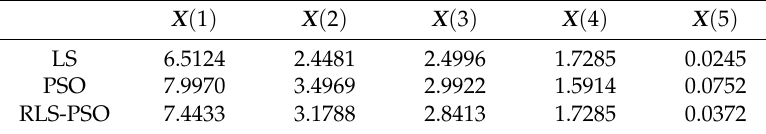
Table 6. The identified values of X ( 1 : 5 ) .